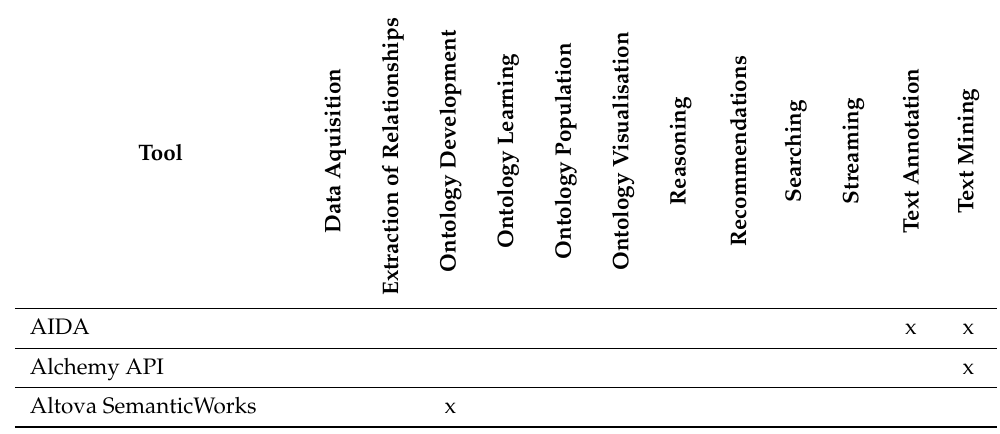
Table 2. Main purpose of the tool (tools